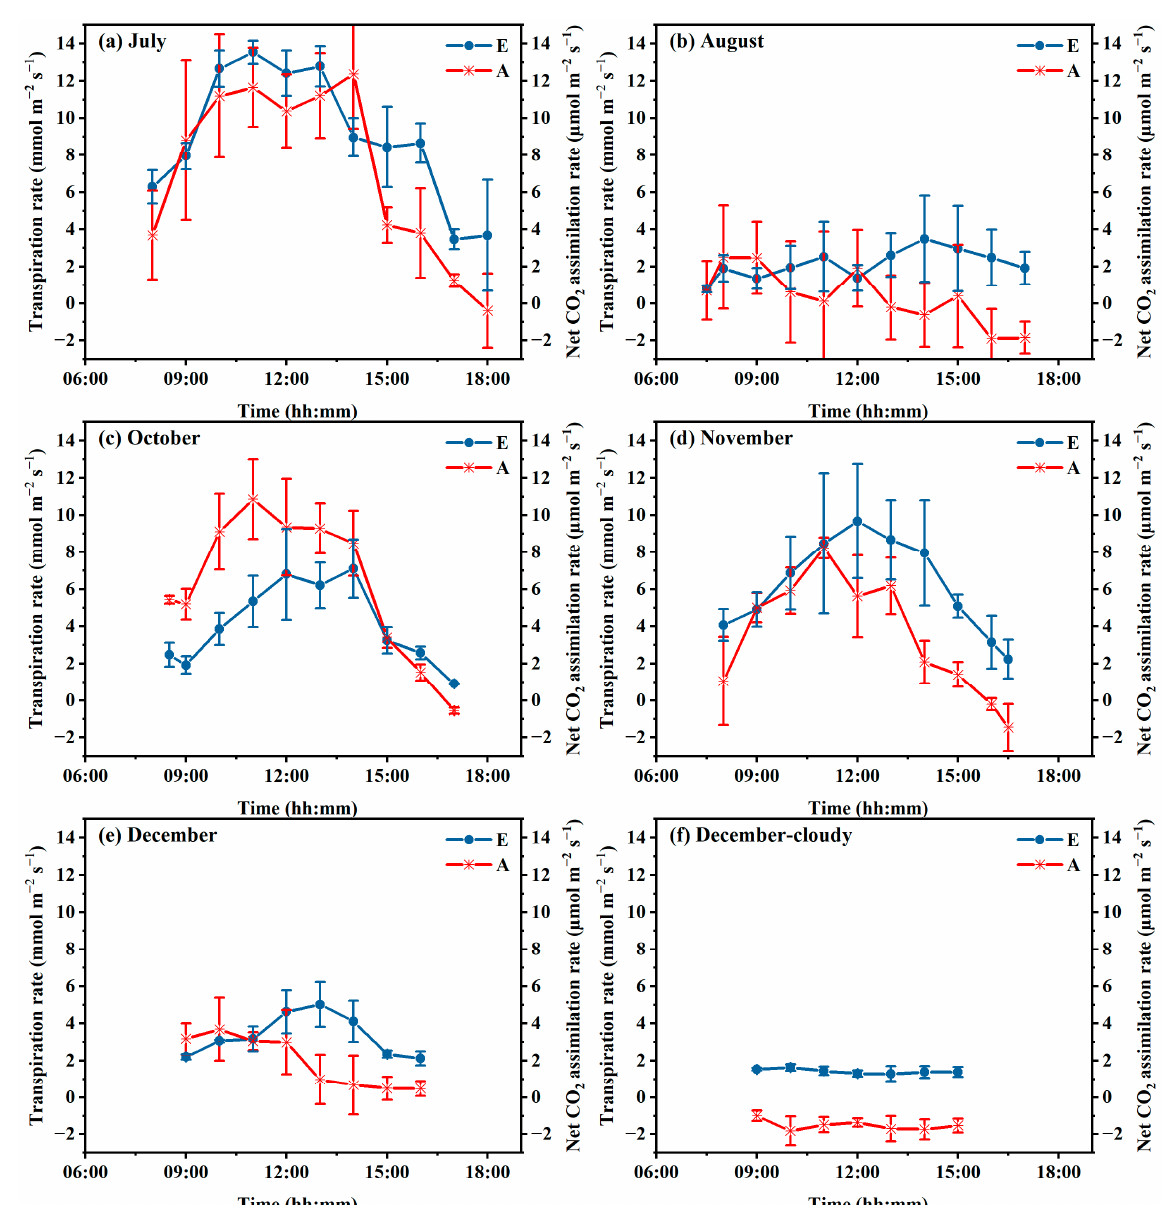
Figure 3. Daily courses of transpiration and photosynthesis rates in July ( a ), October ( c ), November ( d ) and December ( e ) for healthy plants on sunny days, in August ( b ) for diseased plants on sunny days and in cloudy days with healthy plants ( f ).